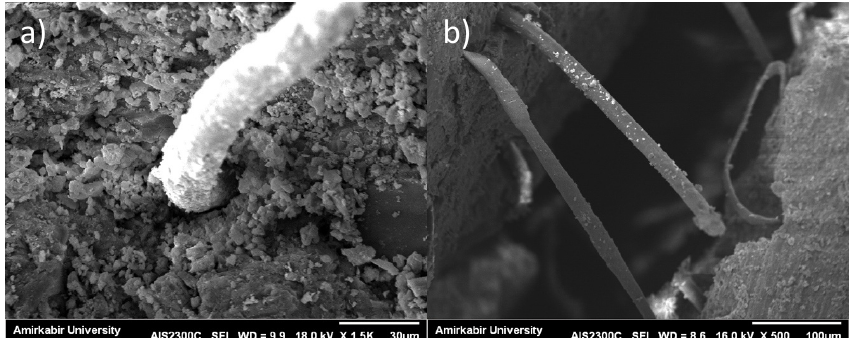
Figure 11. SEM image of: ( a ) PP; and ( b ) PP-MK10NC3.